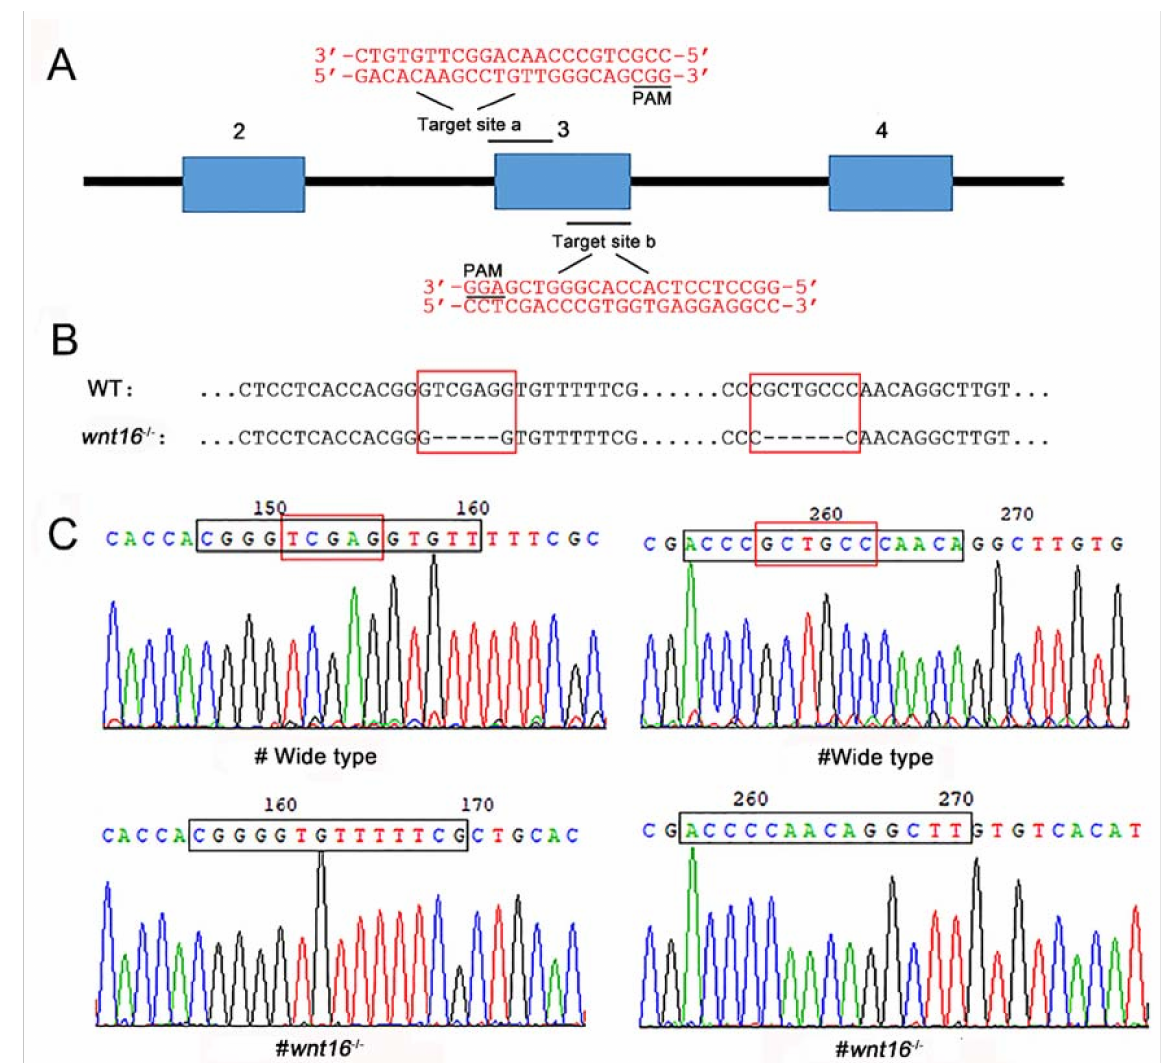
Figure 1. Generation of wnt16 mutant zebrafish with the CRISPR/Cas9 system. ( A ) Schematic diagram of the target site in the zebrafish wnt16 genome. ( B ) Sequence alignment between wildtype (WT) and wnt16 − / − mutant. ( C ) Sequencing maps of WT and wnt16 − / − zebrafish. Black frames: sequences of the target site. Red frames: TCGAG and GCTGCC in WT. Note the 11 bp (TCGAG and GCTGCC) deletion in wnt16 − / −